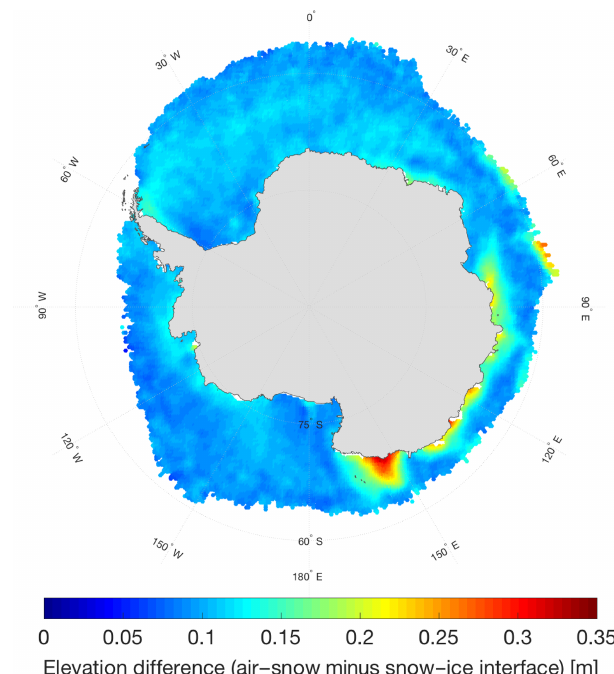
Figure 11. October 2011–2017 average difference between the re- trieved air–snow and snow–ice interfaces as an exploration into the potential retrieval of snow